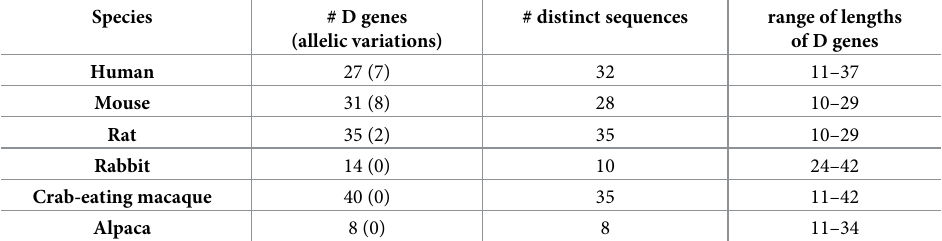
Table 2. Information about the D genes in the IMGT database for various species.